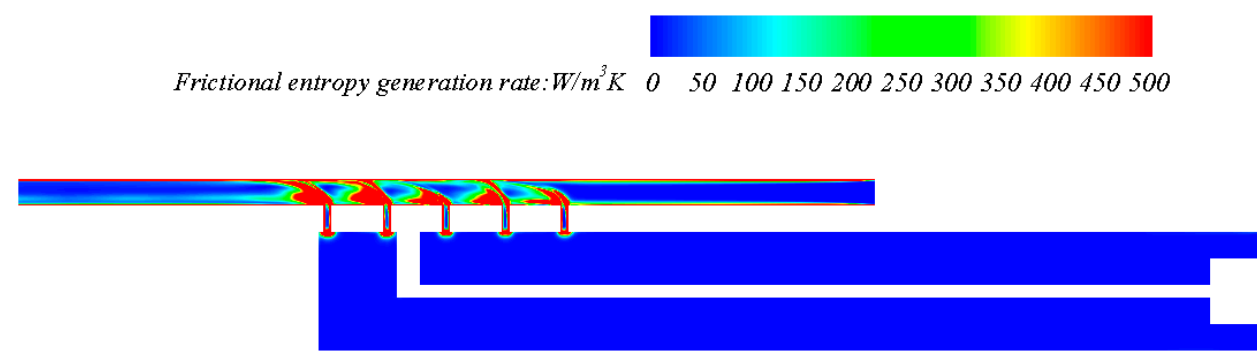
Figure 17. Frictional entropy generation rate in the fluid domain ( x = 28.5 mm, DSJ off).